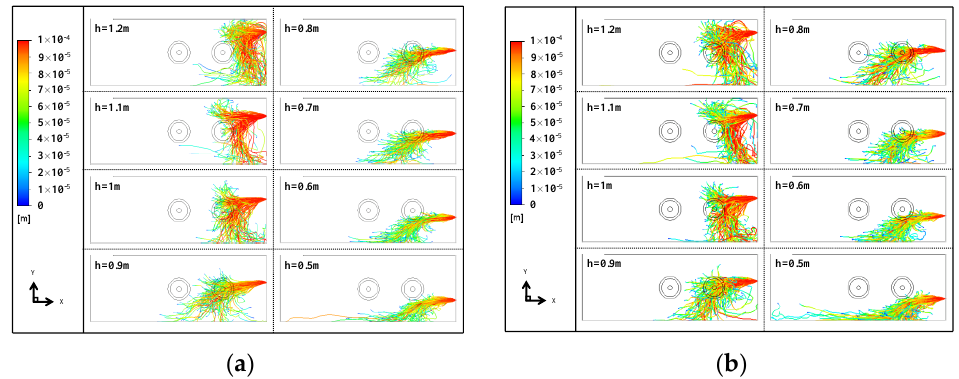
Figure 12. Change of droplet size with trajectory under different nozzle arrangement heights (Z = 1.5 m). ( a ) The burner is symmetrically arranged with reverse swirl. ( b ) Symmetrical arrangement of burners with same direction flow.